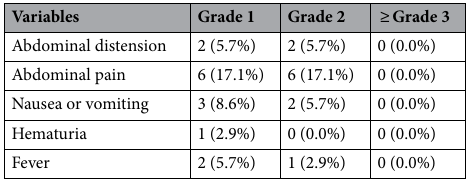
Table 4. Adverse events after